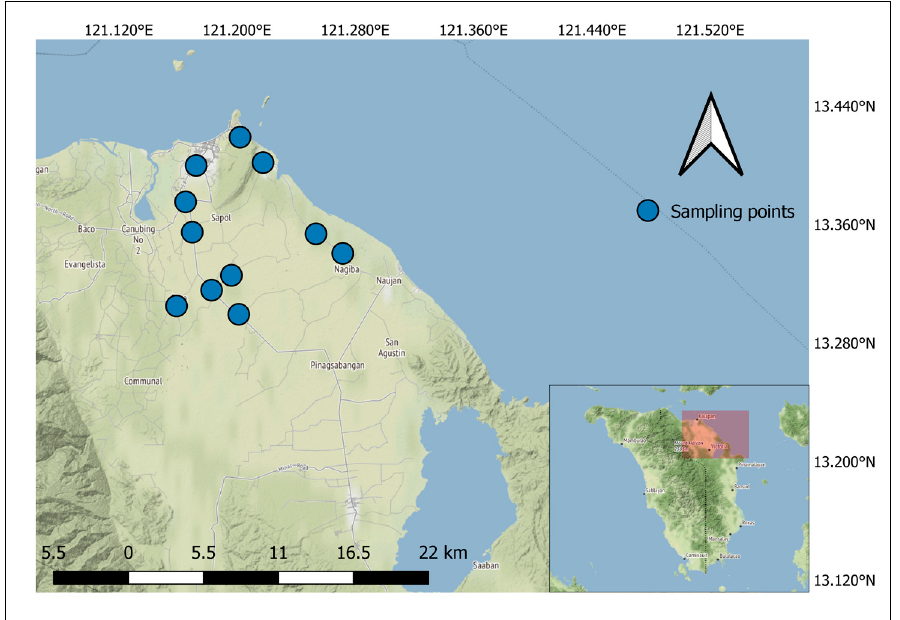
Figure 1. Map of the study area and location of sampling